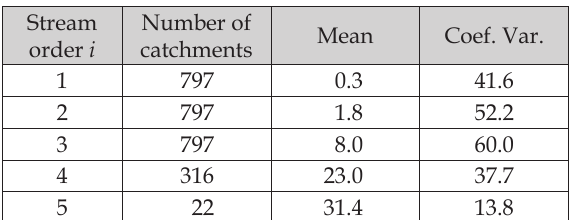
Table 3. Average sub-catchment area of the i order